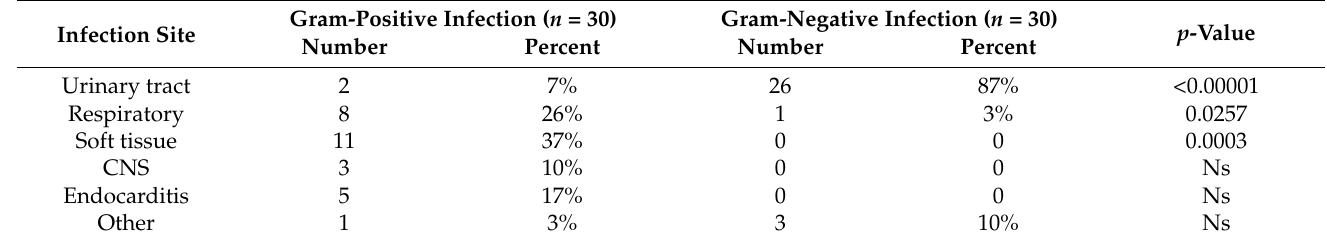
Table 1. The site of infections for 60 sepsis patients with Gram-positive and Gram-negative infections included in the present study. The results are presented as the number and percentage of patients for each of these two patient subsets. Fisher’s exact test was used for the statistical analyses, and the corresponding p -values are presented in the right column (Ns, not